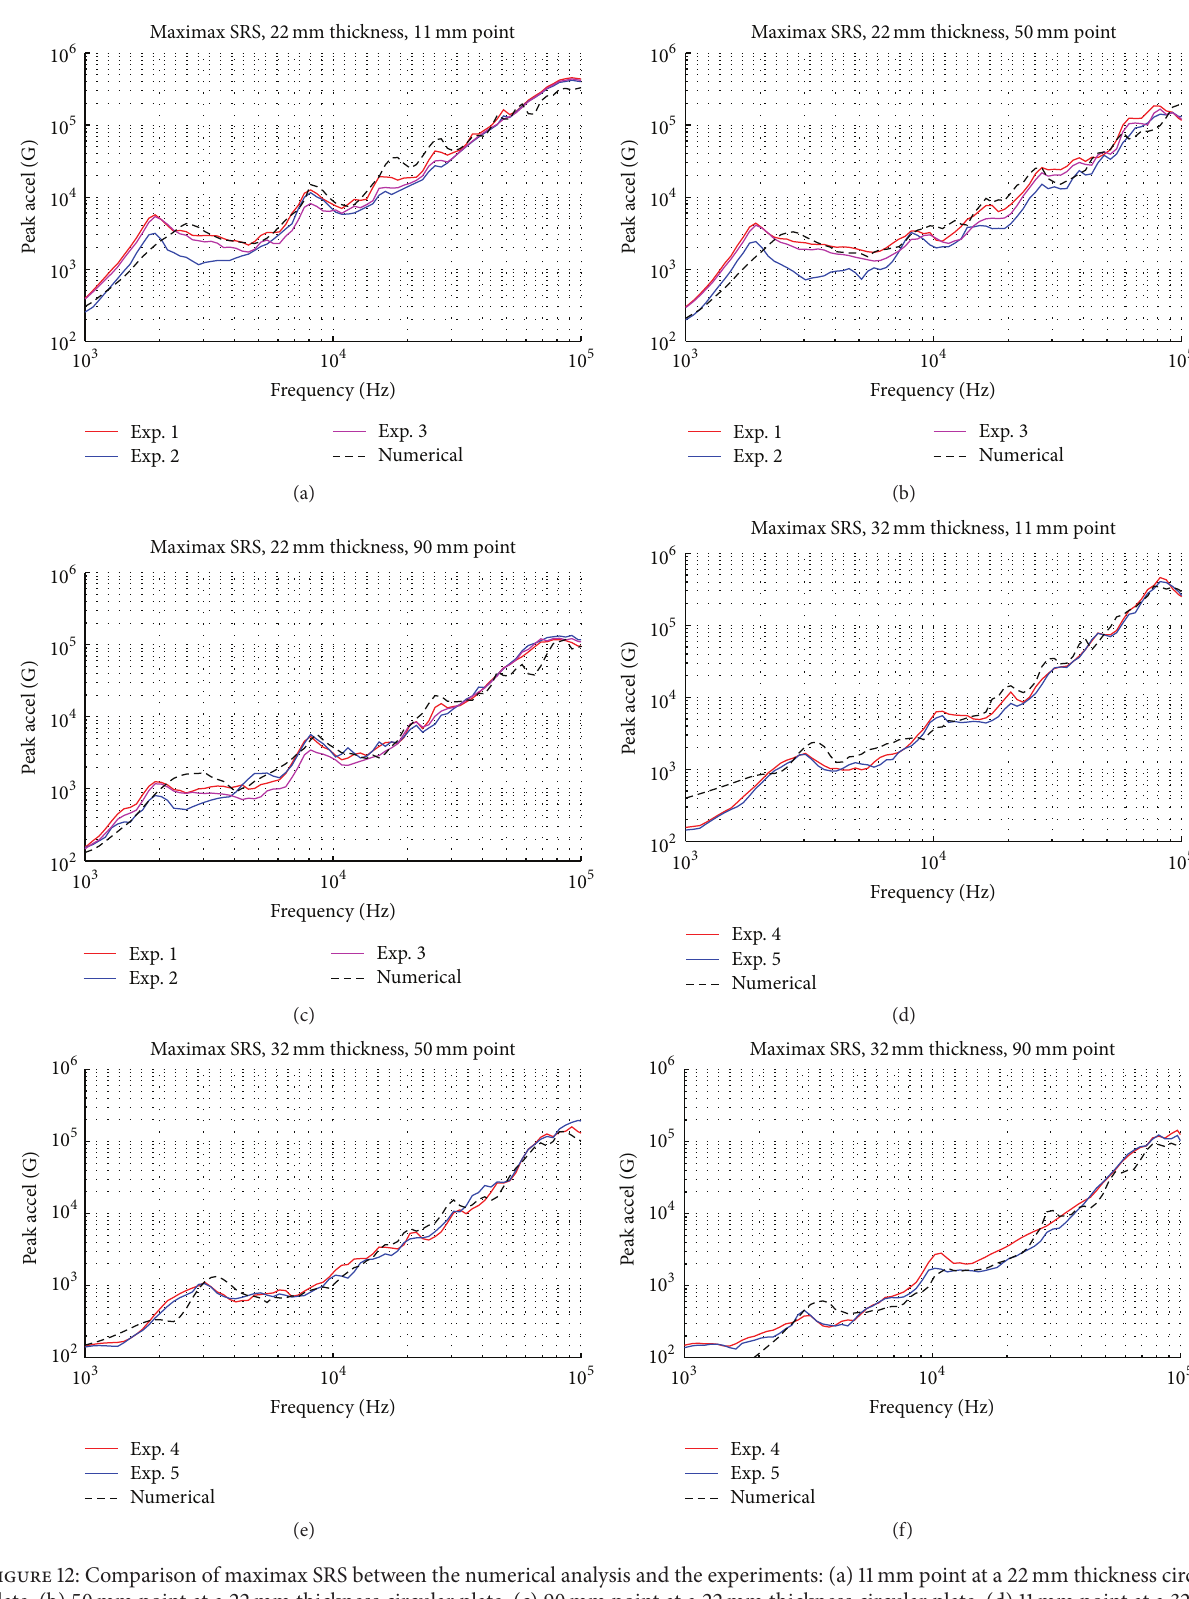
Figure 12: Comparison of maximax SRS between the numerical analysis and the experiments: (a) 11mm point at a 22 mm thickness circular plate, (b) 50 mm point at a 22 mm thickness circular plate, (c) 90 mm point at a 22 mm thickness circular plate, (d) 11mm point at a 32 mm thickness circular plate, (e) 50 mm point at a 32 mm thickness circular plate, and (f) 90mm point at a 32 mm thickness circular